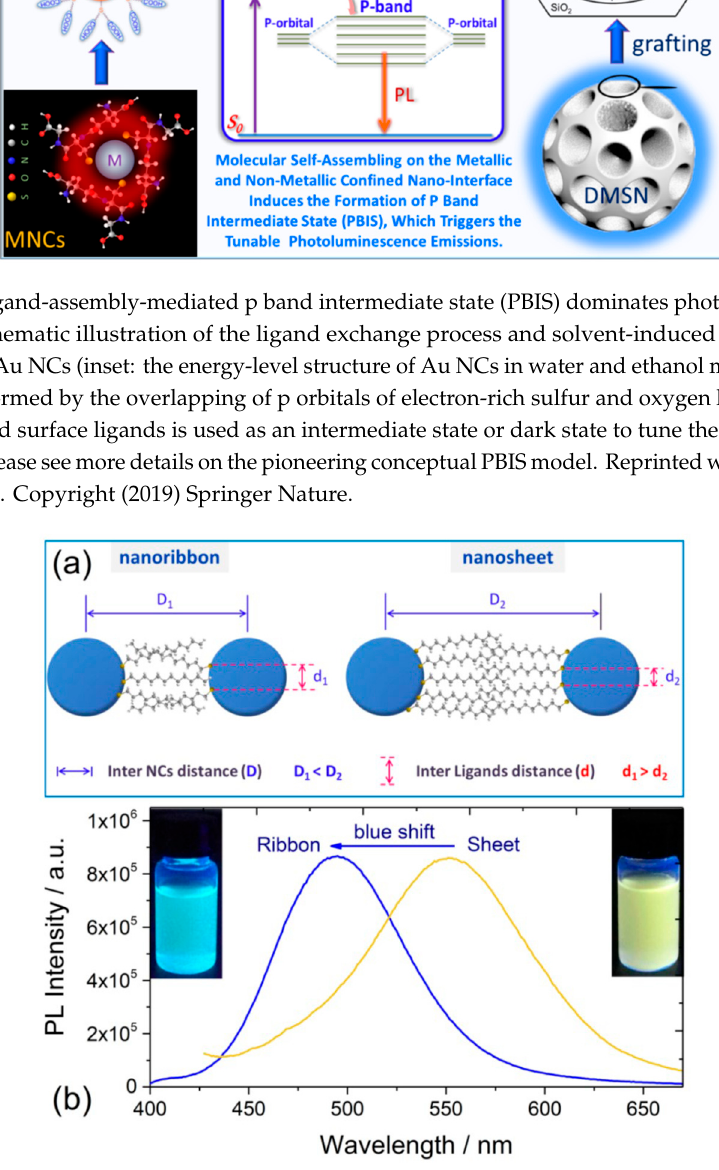
Figure 18. ( a ) Schematic structures of a Cu superlattice with different nanoribbon and nanosheet morphology. ( b ) Corresponding emission spectra of Cu NCs with nanoribbon and nanosheet morphology. The real distance between two thiol groups in the nanoribbon Cu superlattice is larger than that in the nanosheet Cu superlattice, indicating the loose packing of DT molecules on the metal core. The emission peak exhibits a blue shift from 550 nm to 490 nm when the morphology of the Cu superlattice changed from a nanosheet to nanoribbon, which implies a change of the packing model of DT molecules. Reprinted with permission from Ref. [43]. Copyright (2019) Springer Nature.